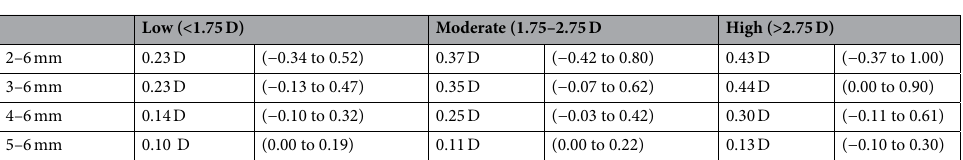
Table 2. The comparison of the median absolute difference (IQR) in astigmatism for corneas with low, moderate, and high